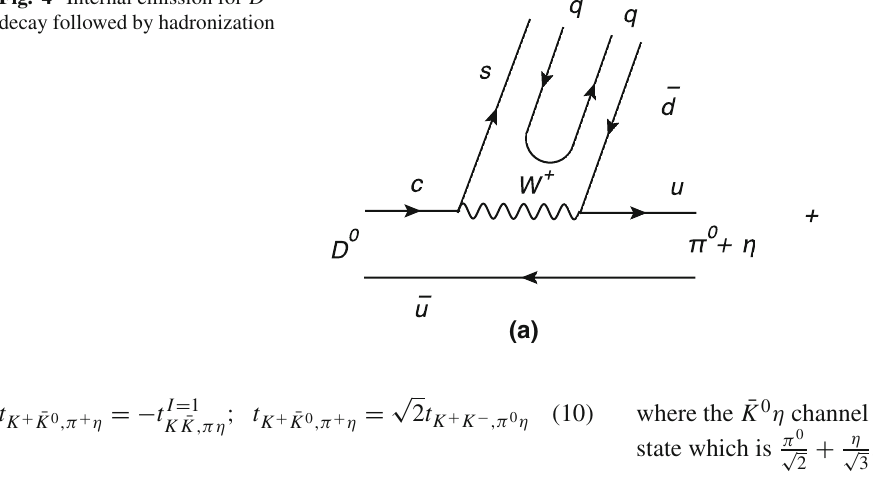
Fig. 4 Internal emission for D